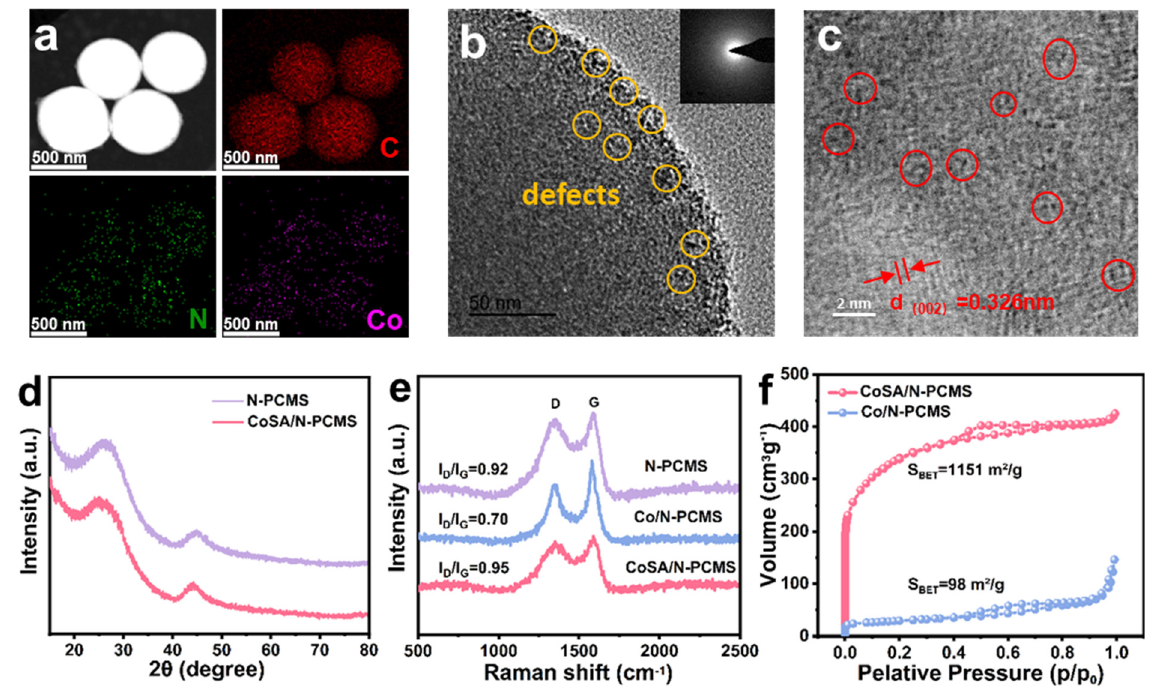
Figure 2. ( a ) Elemental mapping images of CoSA/N − PCMS. ( b ) HRTEM image of CoSA/N − PCMS (inset: corresponding SAED pa tt ern). ( c ) ABF-STEM image of CoSA/N − PCMS. ( d ) XRD pa tt erns and ( e ) Raman spectra of CoSA/N − PCMS and reference samples. ( f ) N 2 adsorption-desorption isotherms of CoSA/N − PCMS and Co/N − PCMS.